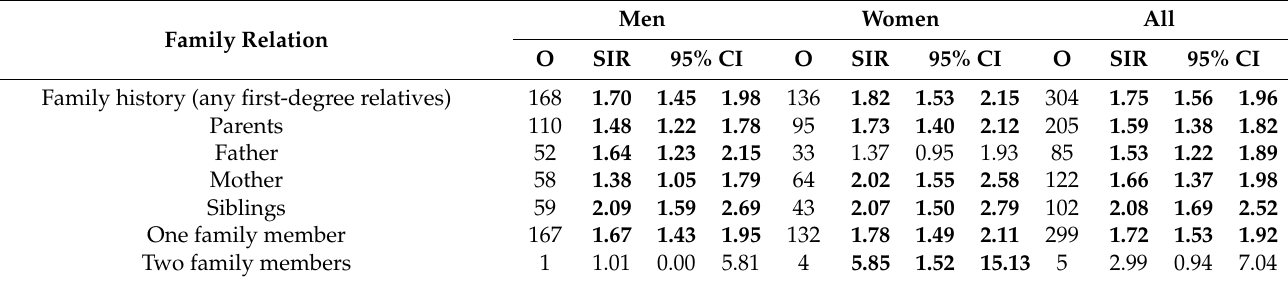
Table 1. Familial risks for concordant hepatobiliary